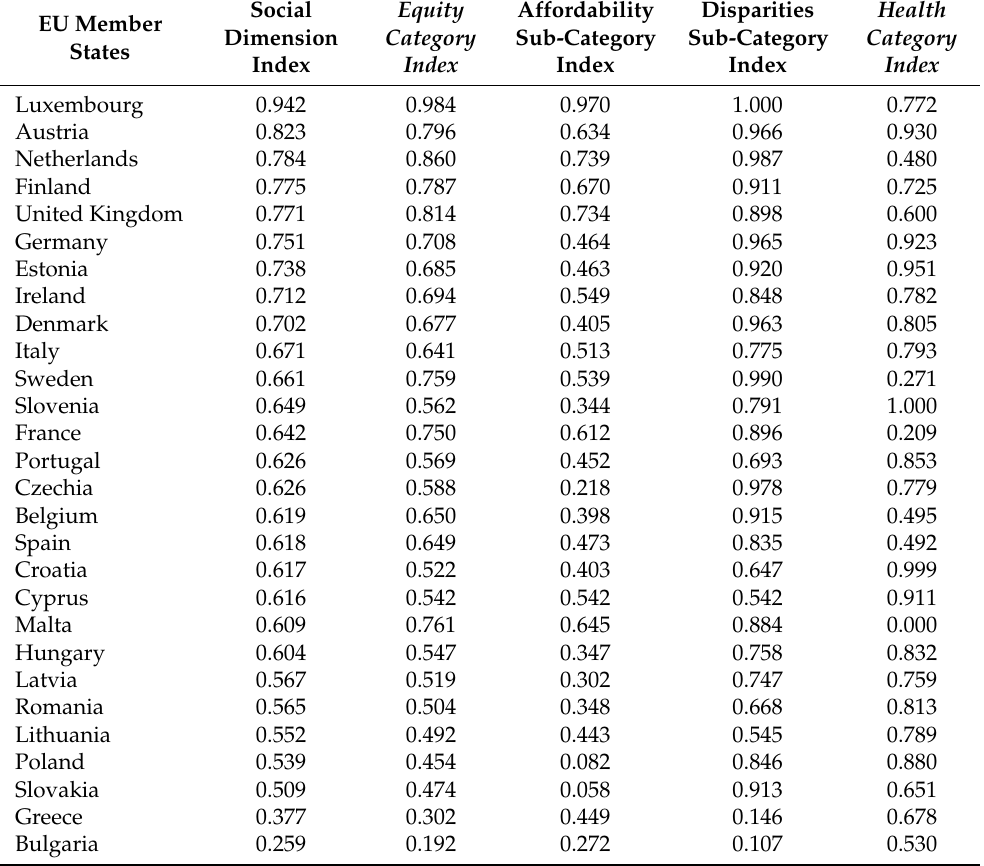
Table 3. Results in social dimension partial